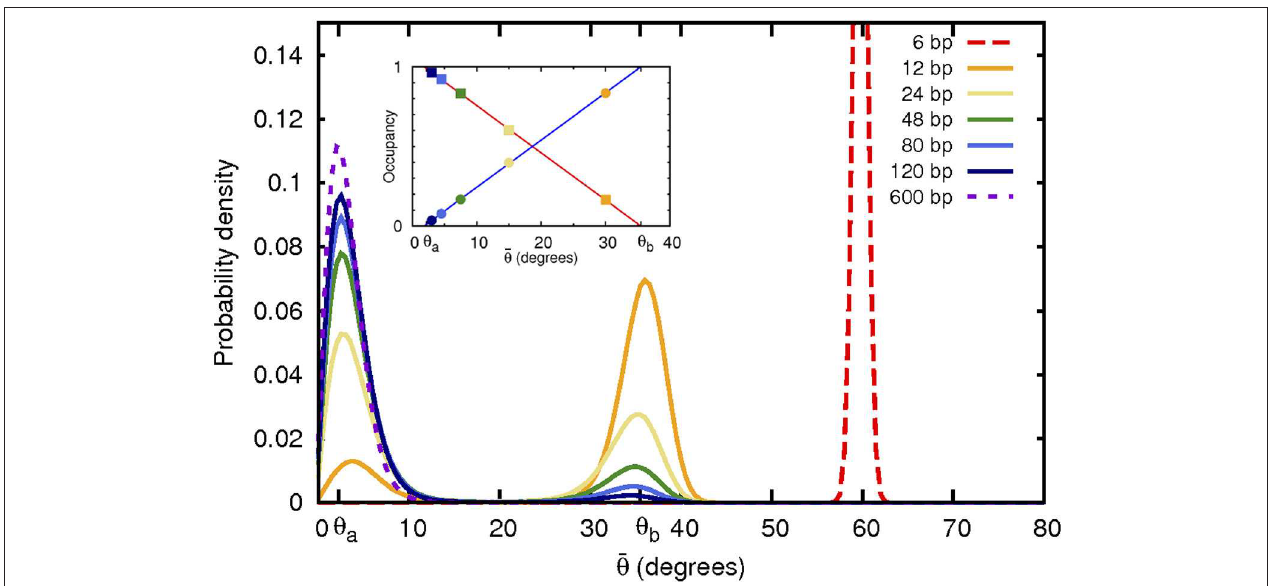
FIGURE 2 | Non-convex bending energy function leads to bi-modal distribution of bending angles. Shown are angular probability distributions at 300 K resulting from a realistic non-convex bending potential ( Figure 4 ) used here in coarse-grained simulations of DNA closed loops of variable size. As the loop size (indicated in the top right corner) decreases, the average bending angle per base pair increases. When the average angle falls into the convex hull range, the angular distribution becomes bi-modal with peaks at θ a and θ b , corresponding to the weakly and strongly bent states, respectively. Fractional occupancy of both of these states of bending is shown in the inset as a function of the average bend angle ¯ θ . Squares: occupancy of the weakly bent state. Circles: occupancy of the strongly bent state, which can be interpreted as a “kink.” Out-of-plane motion likely affects angular probability distribution of the largest (600 bp) loop, which may explain the shift, compared to expectation, of the position of the corresponding distribution peak.